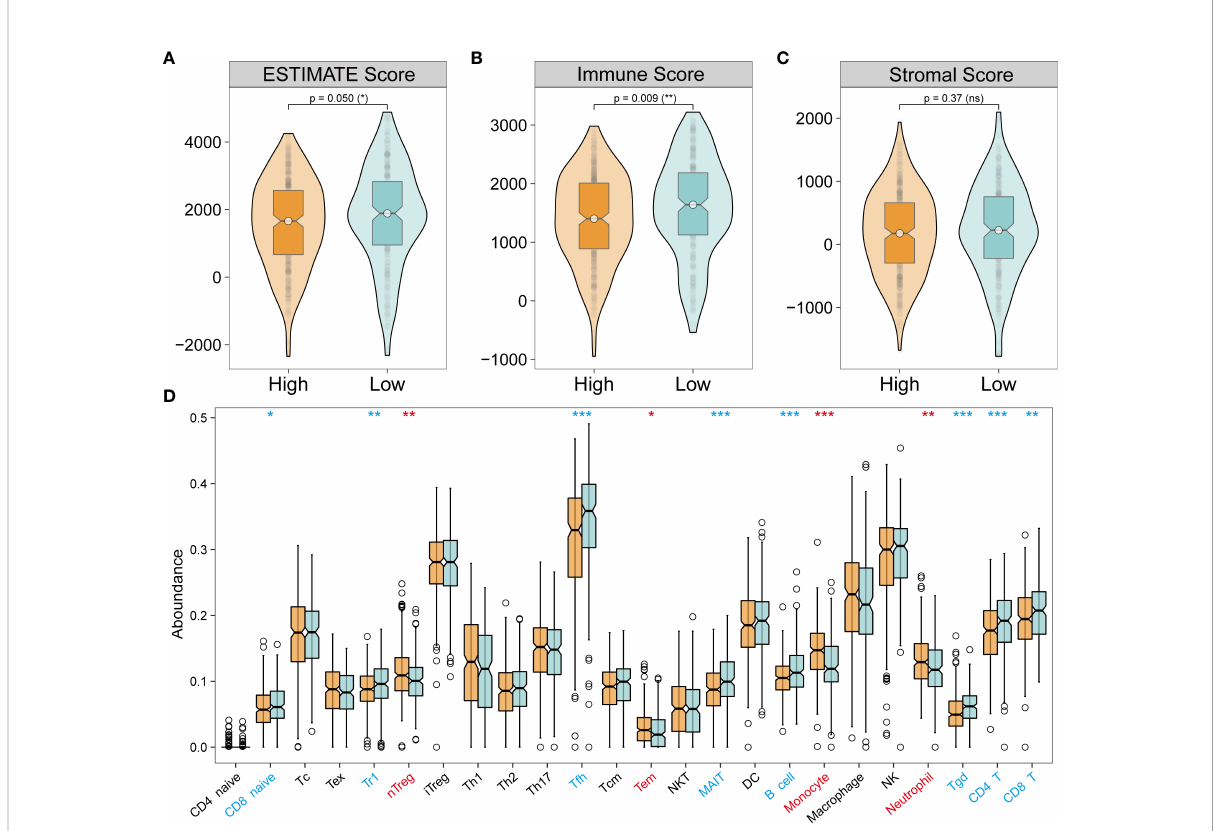
FIGURE 5 Tumor immune landscape of NecroLRS-High and -Low groups. (A – C) ESTIMATE algorithm reveals that the NecroLRS-High group has a lower ESTIMATE and immune score compared with the NecroLRS-Low group. (D) ImmuneCellAI algorithm reveals immune cell abundance across NecroLRS-High and -Low groups. *P < 0.05; **P < 0.01; ***P < 0.001; ns, P ≥